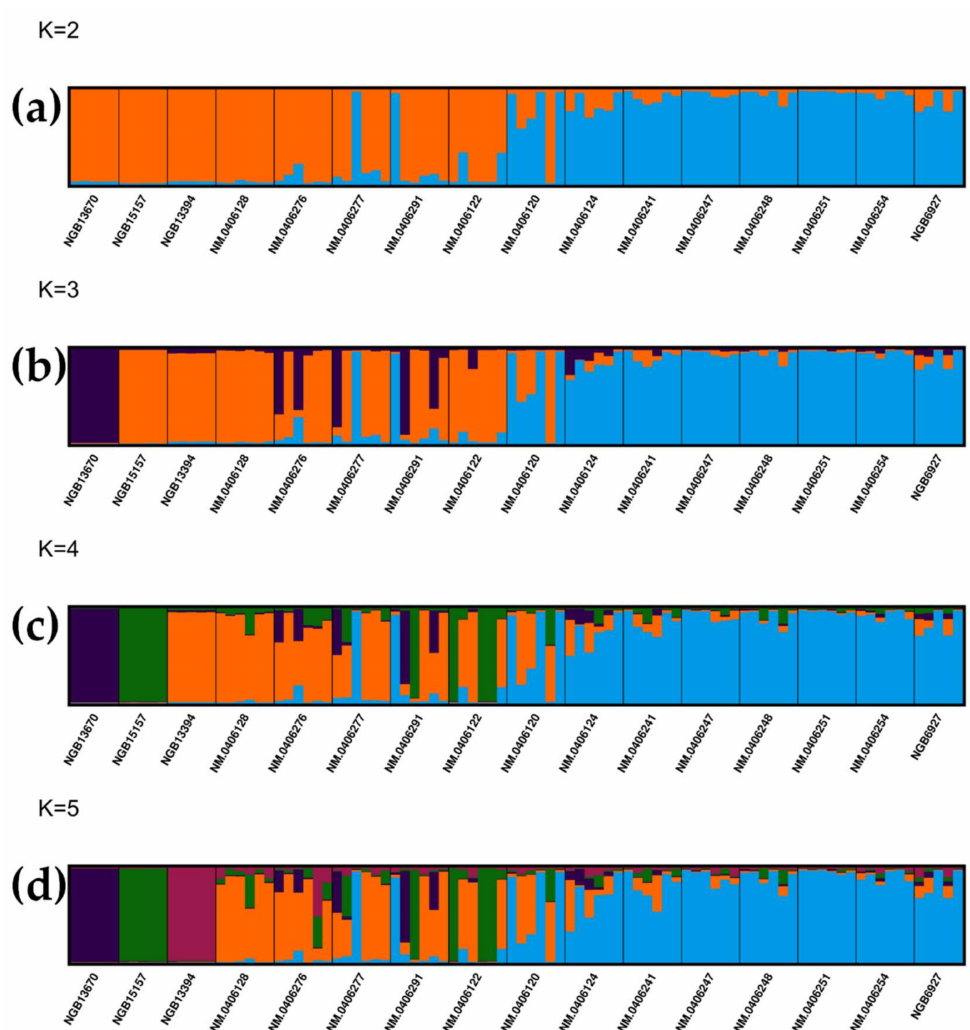
Figure 1. Bar plots of Structure analysis (CLUMPP output) assuming two to five clusters (K). Each line represents one individual, and the length of each color section shows the proportion of the individual’s genetic diversity belonging to a specific cluster. Results of Structure analysis assuming ( a ) two clusters ( b ) three clusters ( c ) four clusters ( d ) five